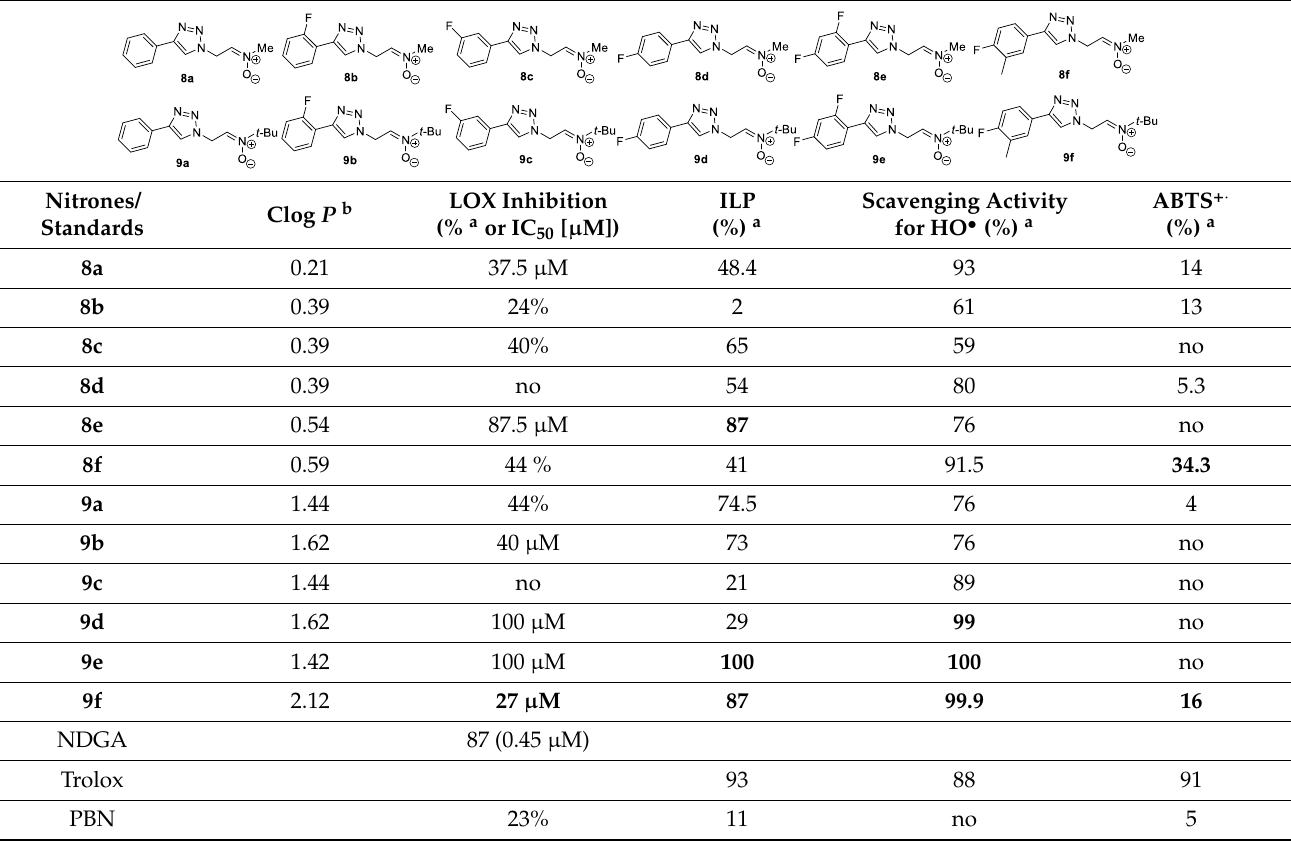
Table 1. In vitro antioxidant activities of nitrones 8a – f and 9a – f